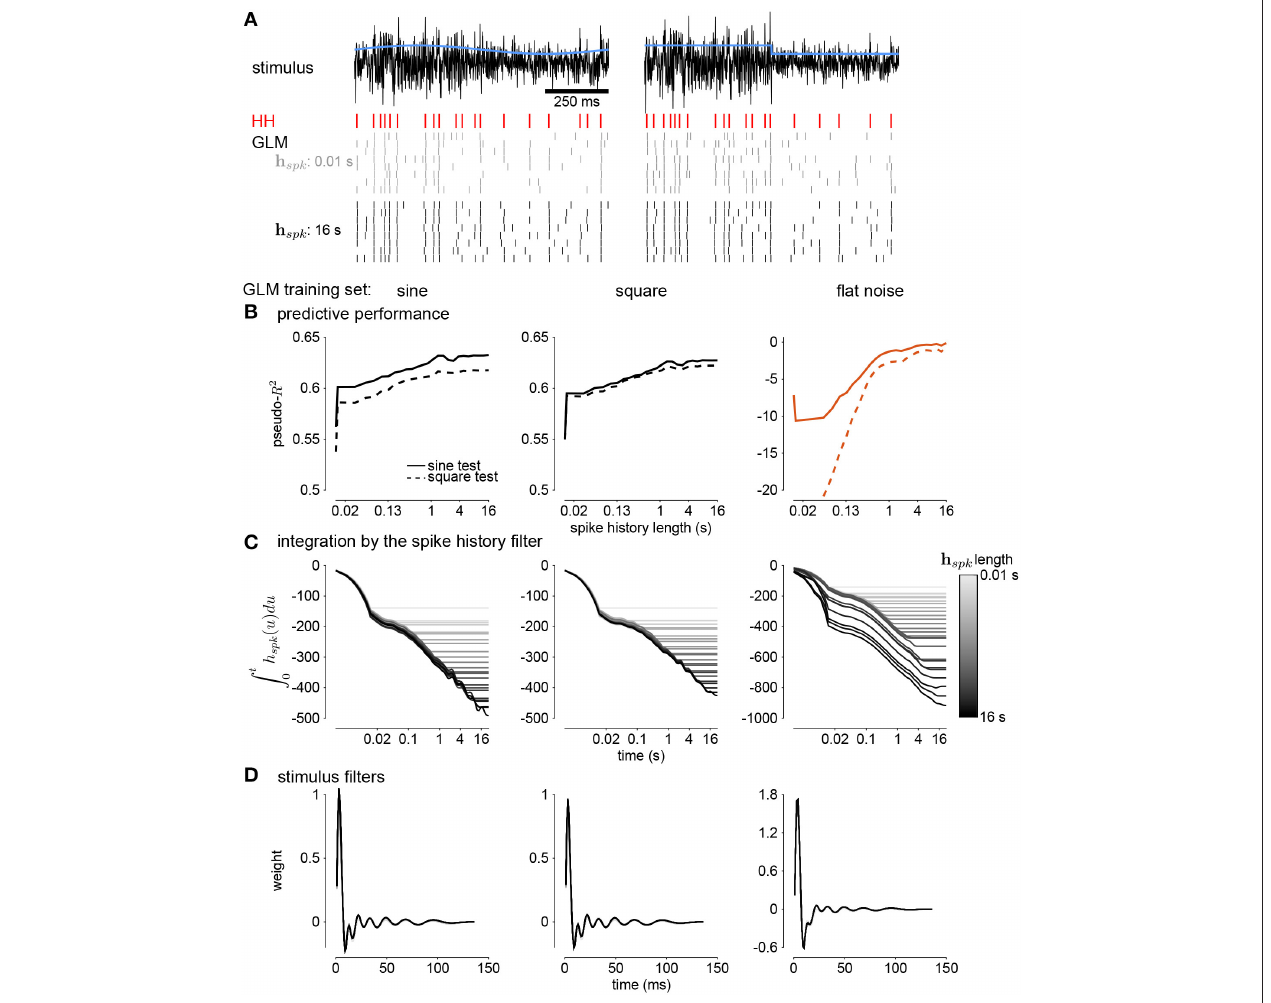
FIGURE 10 | (A) Comparing simulations of the HH model to sine wave modulated (left) and square wave modulated (right) noise. The black traces show the stimulus and the blue traces show the standard deviation envelope. The red raster denotes the HH spike response. Several repeated simulations of the GLM are shown for a GLM trained with only a 10 ms spike history (gray raster) and a GLM trained with the full 16 s spike history (black raster). (B) Assessing the model fitness for GLMs fit to sine wave modulated noise (left), square wave noise (middle), and unmodulated noise (right). The pseudo- R 2 measured on a withheld training set simulated from the HH model as a function of spike history length. The stimulus was sine (solid lines) or square (dashed lines) modulated noise with a 4 s period and a modulation strength of σ = 2. (C) The integral over time (i.e., cumulative sums) of each spike history filter. (D) The stimulus filters for all GLM